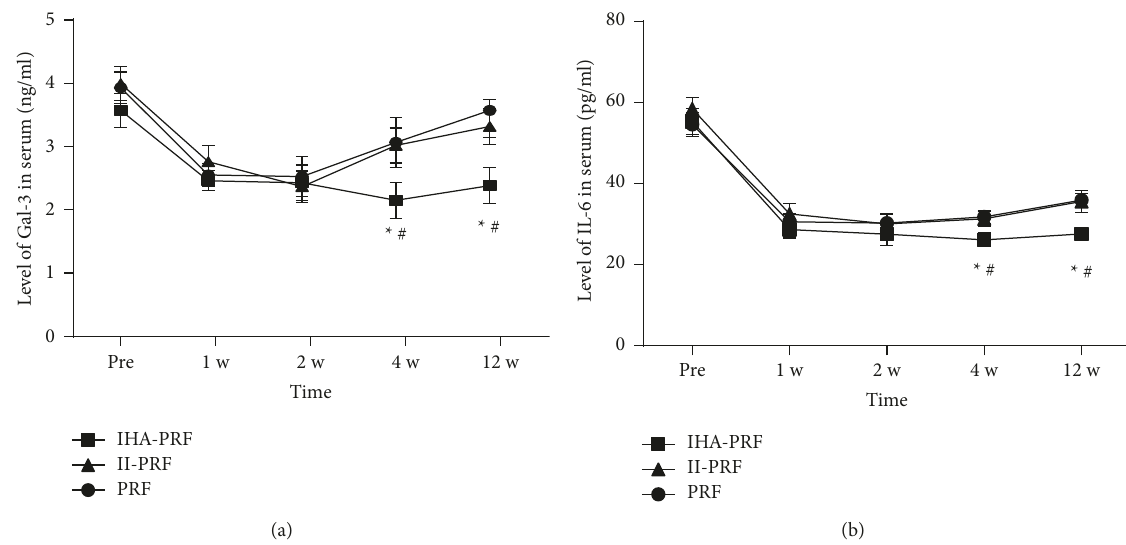
Figure 5: Following treatment in group IHA-PRF, plasma amount of Gal-3 (a) and IL-6 (b) decreased in each group. Compared to II-PRF and PRF groups, the amount of Gal-3 and IL-6 in plasma of patients in group IHA-PRF significantly decreased 4 and 12 weeks after treatment. Compared with group II-PRF, ∗ P < 0 . 05. # P < 0 . 05, compared with group PRF.